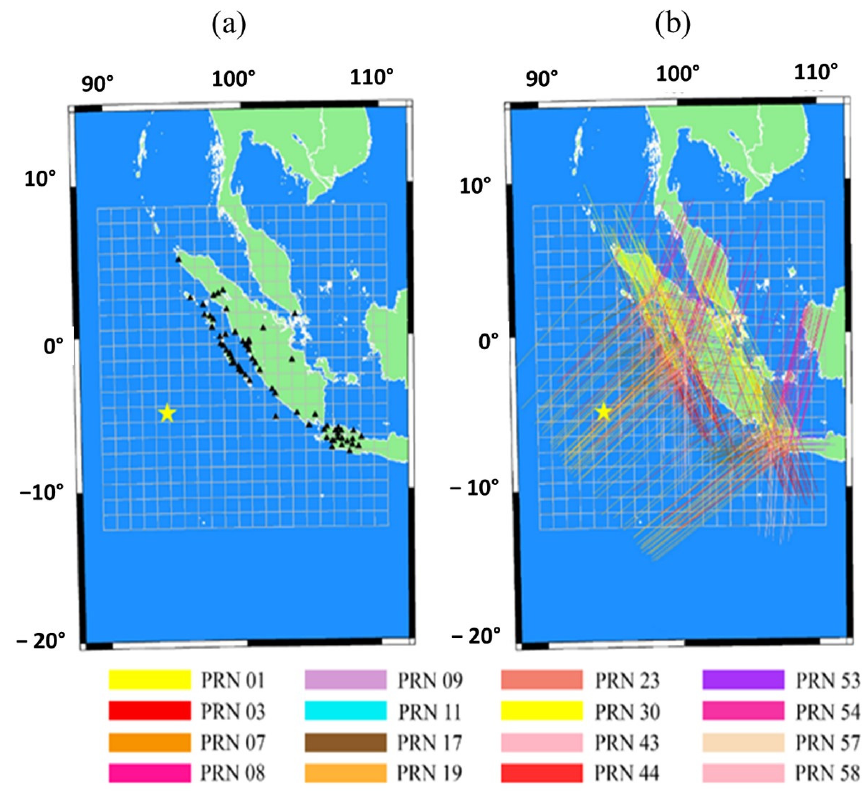
Figure 1. ( a ) shows the Tomographic voxel setup and the distribution of observation stations on the island of Sumatra, with ( b ) the distribution of LoS when the earthquake occurred. The small black triangles indicate the location of the GNSS observation stations, while the white grids indicate the tomographic voxel setup. The colorful straight lines indicate the LoS distribution, and the small yellow star indicates the location of the earthquake